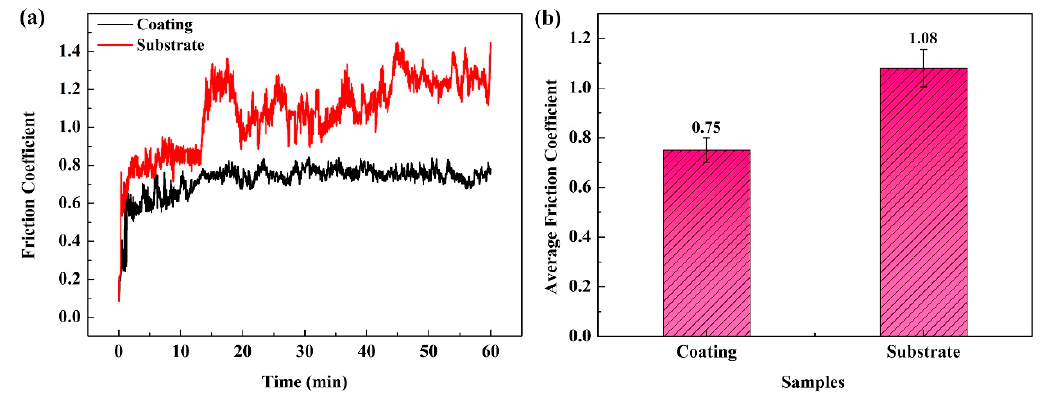
Figure 8. The variation of friction coefficient with time ( a ) and average friction coefficient ( b ) of the tested samples.